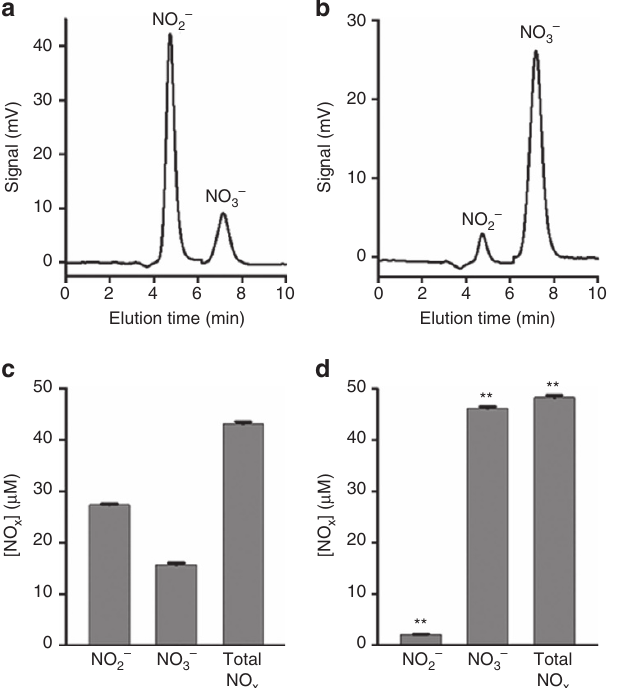
Figure 2 | NO dioxygenase activity of cytoglobin. Nitrite and nitrate measurements of DEA-NONOate-treated samples without Cygb ( a , c ) and with the addition of 2 m M Cygb ( b , d ). Example elution profiles from the ENO-20 NOx analyzer for control ( a ) and Cygb ( b ) samples, with the corresponding concentrations in c , d , respectively. Addition of Cygb results in 96% of NOx as nitrate versus 36% in control. Nitrite comprises 64% of NOx in control but decreases to 4% in the Cygb samples. Error bars: mean ± s.e.m., n ¼ 4 per group; ** P o 0.01 for Cygb versus control with no Cygb; P values determined using a two-tailed t -test.